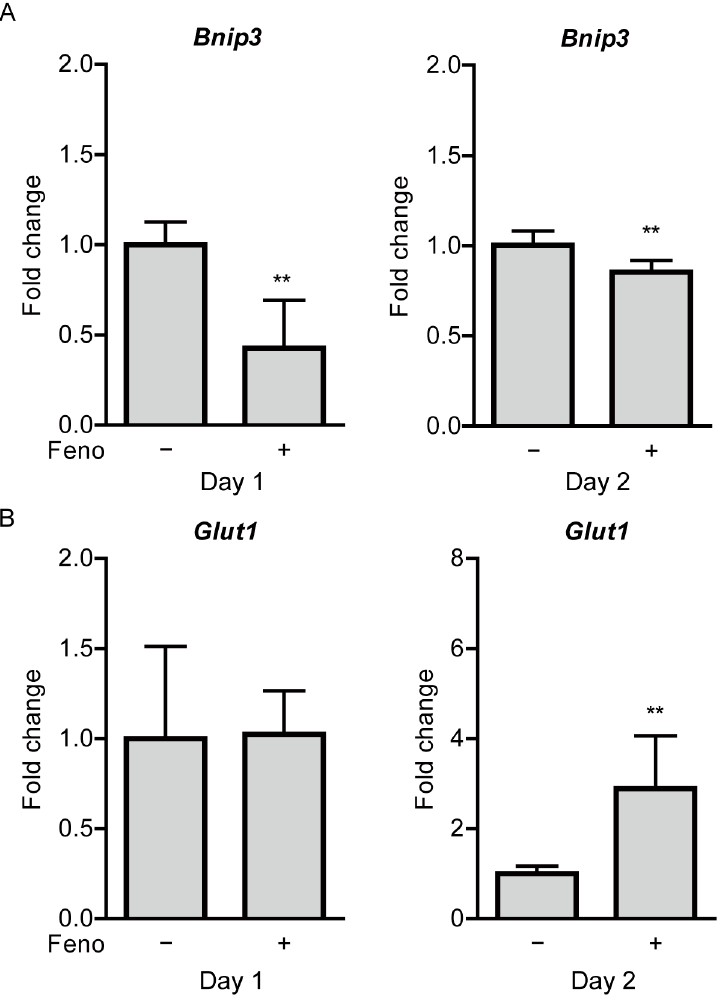
Figure 7. Modulation of retinal hypoxia-responsive gene expressions by oral administration of fenofibrate in the UCCAO-operated mice. ( A ) Quantitative analyses ( n = 4–7 per group) show that oral administration of fenofibrate significantly reduced increases in expressions of Bnip3 in the retina 1 and 2 days after UCCAO. ( B ) Quantitative analyses ( n = 4–7 per group) show that oral administration of fenofibrate increased Glut1 expressions in the retina 2 days after UCCAO. ** p < 0.01. The data were analyzed using Student’s t -test (two-tailed) and presented as mean ± standard deviation. Feno; fenofibrate. UCCAO; unilateral common carotid artery occlusion.